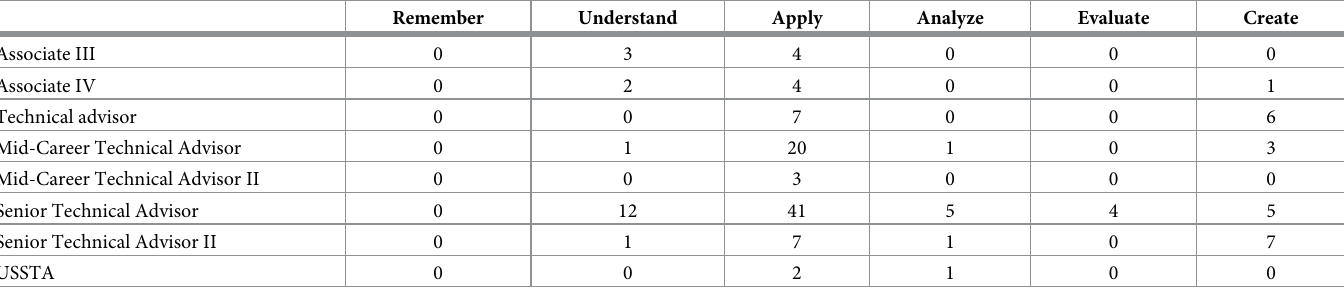
Table 3. Level of Bloom’s Taxonomy for each learning objective by position title �